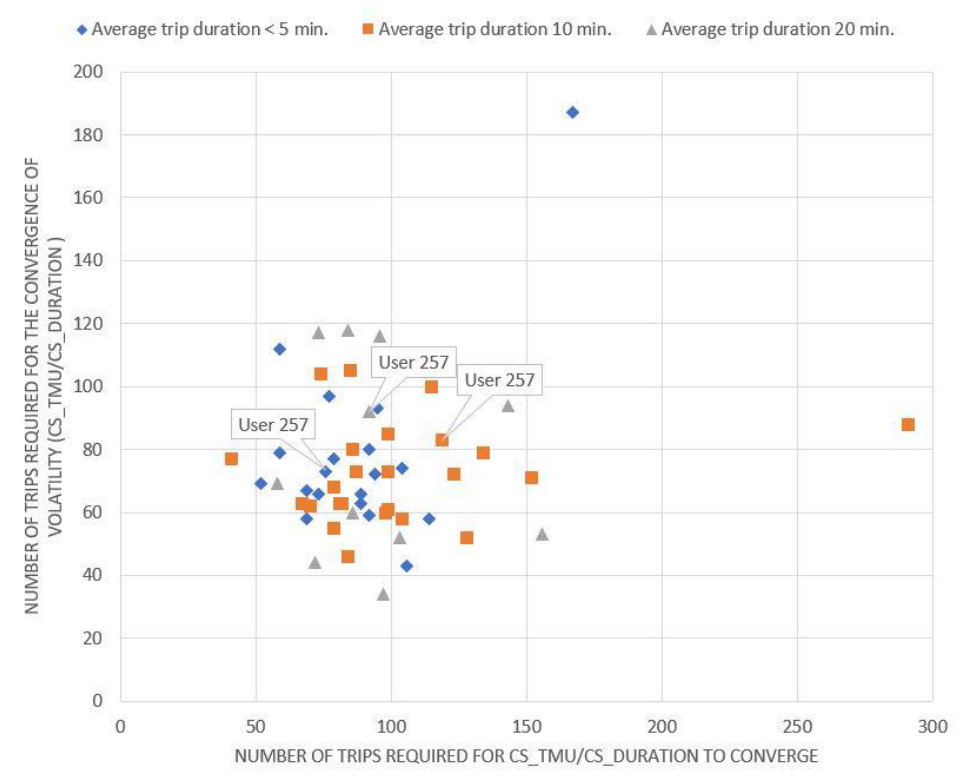
Figure 3. Minimum number of trips required for the percentage of time mobile usage rate to converge.